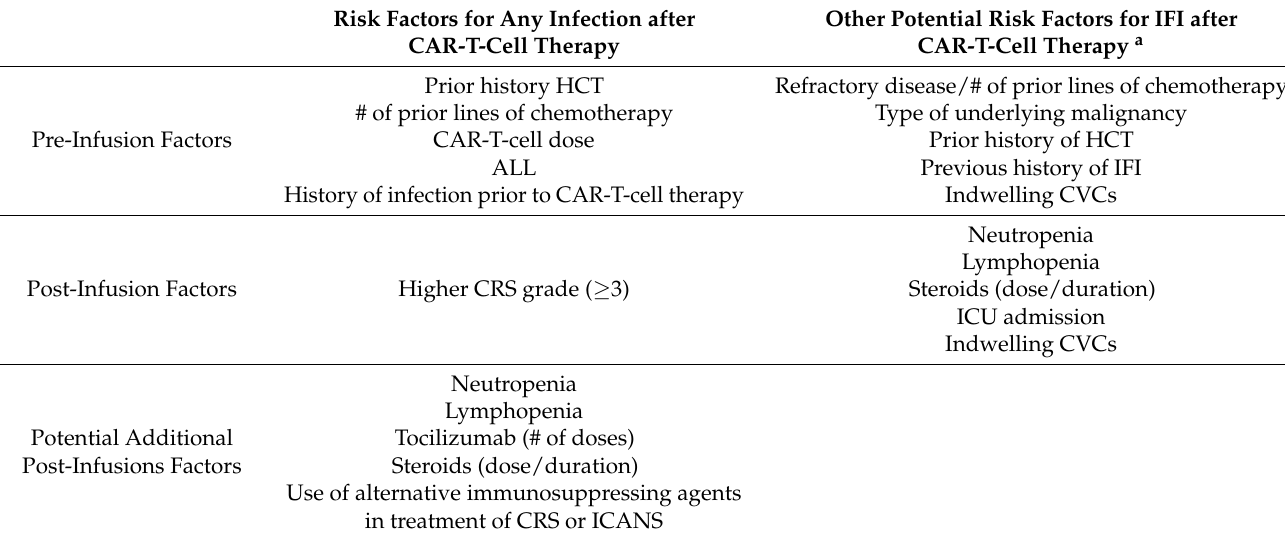
Table 4. Known and proposed risk factors for general infection and invasive fungal infections after CAR-T-cell therapy. HCT = hematopoietic cell transplant; CAR-T-cell = chimeric antigen receptor-modified T-cell; ALL = acute lymphoblastic leukemia; CRS = cytokine release syndrome; IFI = invasive fungal infection; CVCs = central venous catheters; CLL = chronic lymphocytic leukemia; DLBCL = diffuse large B-cell lymphoma; ICANS = immune effector cell-associated neurotoxicity syndrome. a Other potential, but less well-studied IFI risk factors include malignancy type (ALL vs. CLL vs. DLBCL), tocilizumab (number of doses), and use of alternative immunosuppressing agents in treatment of CRS or ICANS = immune effector cell-associated neurotoxicity